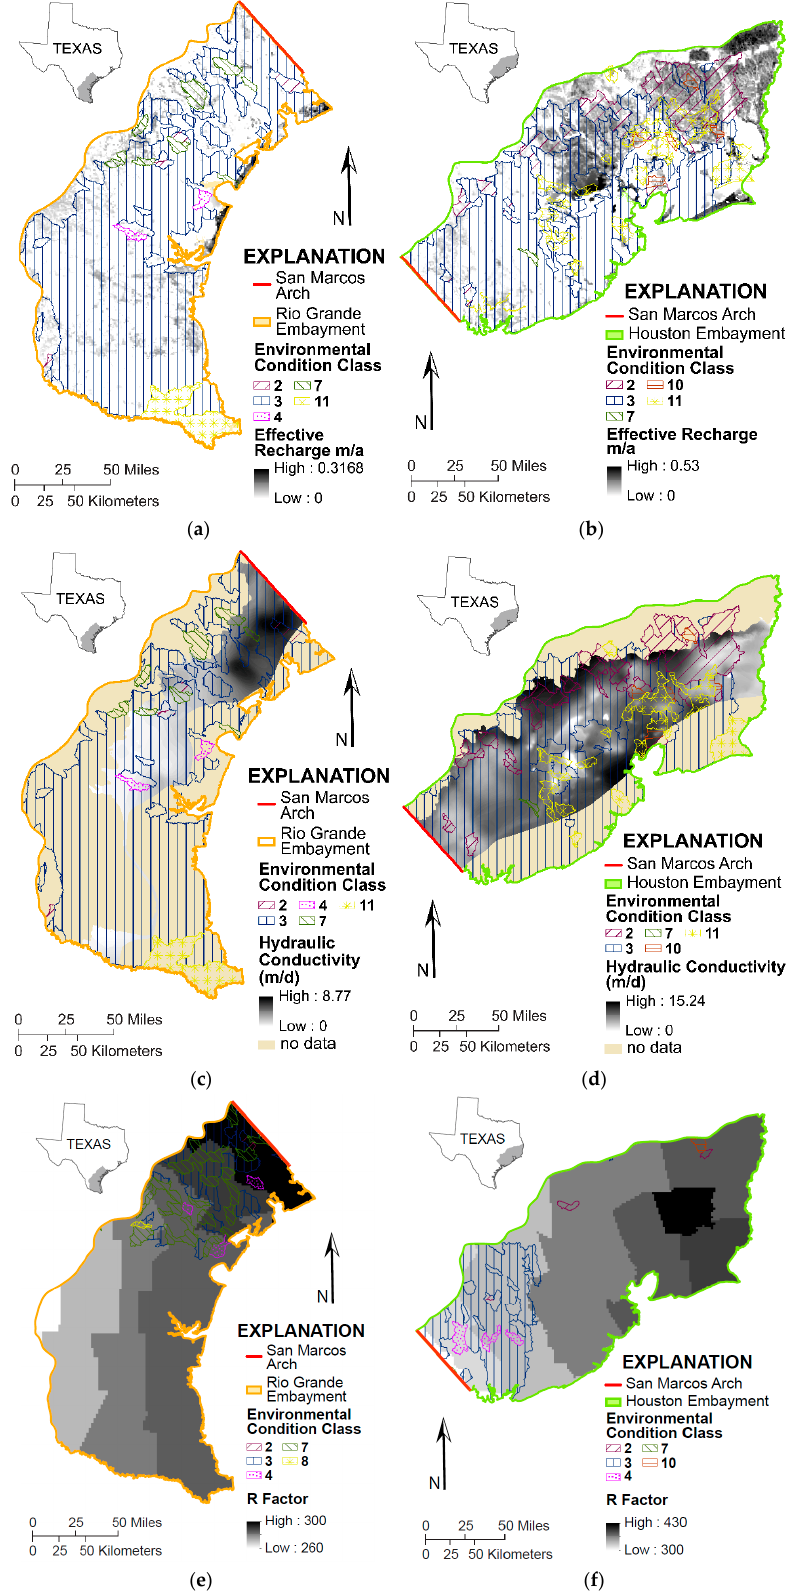
Figure 7. Maps indicating the potential for the persistence of ( a , b ) surface ‐ derived COPCs in groundwater, ( c , d ) the migration of COPCs into adjacent aquifers, and ( e , f ) the runoff of COPCs from wastes stored at the surface into surface waters in the Rio Grande and Houston Embayments. Note that gray scales are different for each map. The two ‐ factor maps also highlight the indicators of physical mobility in areas of dif ‐ fering potential for chemical mobility in groundwater or surface water (Figure 7) accord ‐ ing to the geochemical environmental conditions outlined by Blake et al. [7]. Environmen ‐ tal Condition 2 has the highest effective recharge in the Houston Embayment, but has a lower likelihood of samples being greater than 0.2 μ g/L of uranium according to Blake et al. (Figure 7a,b and Table 3) [7]. Conversely, Environmental Condition 7, which has a higher likelihood of uranium mobility [7], has the lowest average effective recharge.